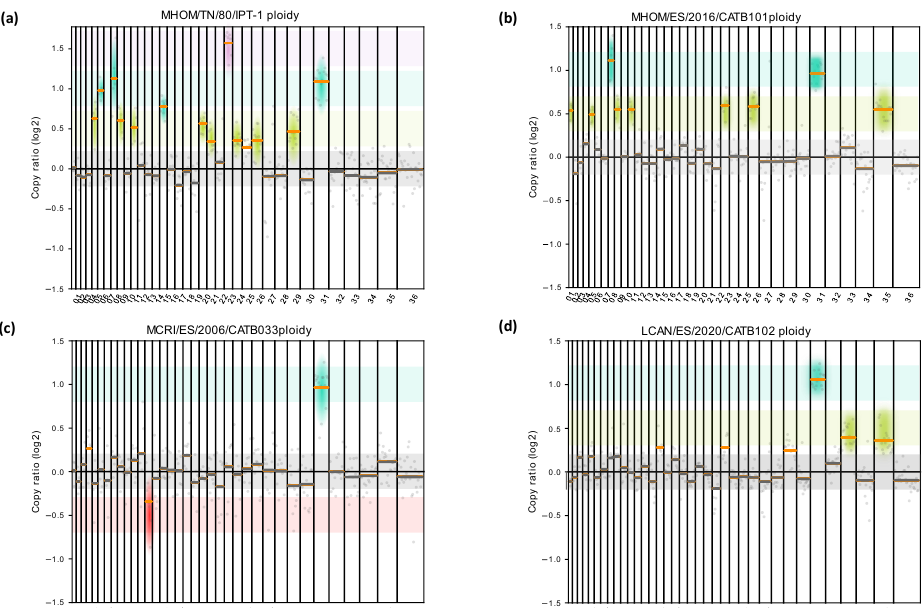
Figure 2. Detection and quantification of different aneuploidy patterns among L. infantum cultures. Aneuploidy analysis was carried out by adapting the sliding window size to 100 kbp (gray dots) for MHOM/TN/80/IPT-1 ( a ), MHOM/ES/2016/CATB101 ( b ), LCAN/ES/2020/CATB102 ( c ), and MCRI/ES/2006/CATB033 ( d ). Copy ratio represents the fold change of expected and observed chromosomal dotation. The median copy ratio is represented in orange if significantly different than 0 or in gray if not significant. Monosomy is highlighted with red shadowing, disomies with gray, trisomies with green, tetrasomies in turquoise, and hexasomies or larger in violet. No pentasomies were observed.